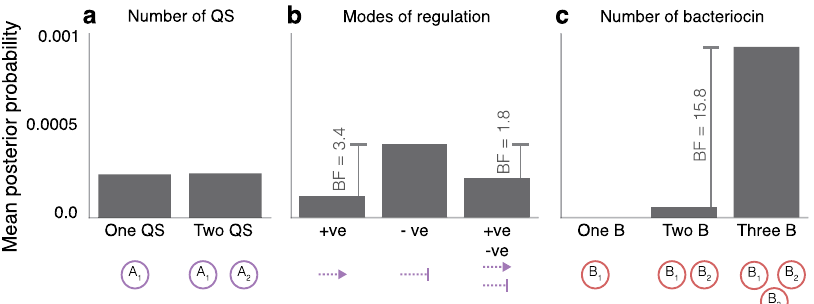
Fig. 5 Average posterior probabilities associated with the number of genetic parts. a Comparing systems with one and two orthogonal QS parts. b Comparing modes of bacteriocin regulation in the system by subsetting for systems with induction ( + ve), repression ( − ve) or both ( + ve, − ve). c Comparing systems with one, two and three